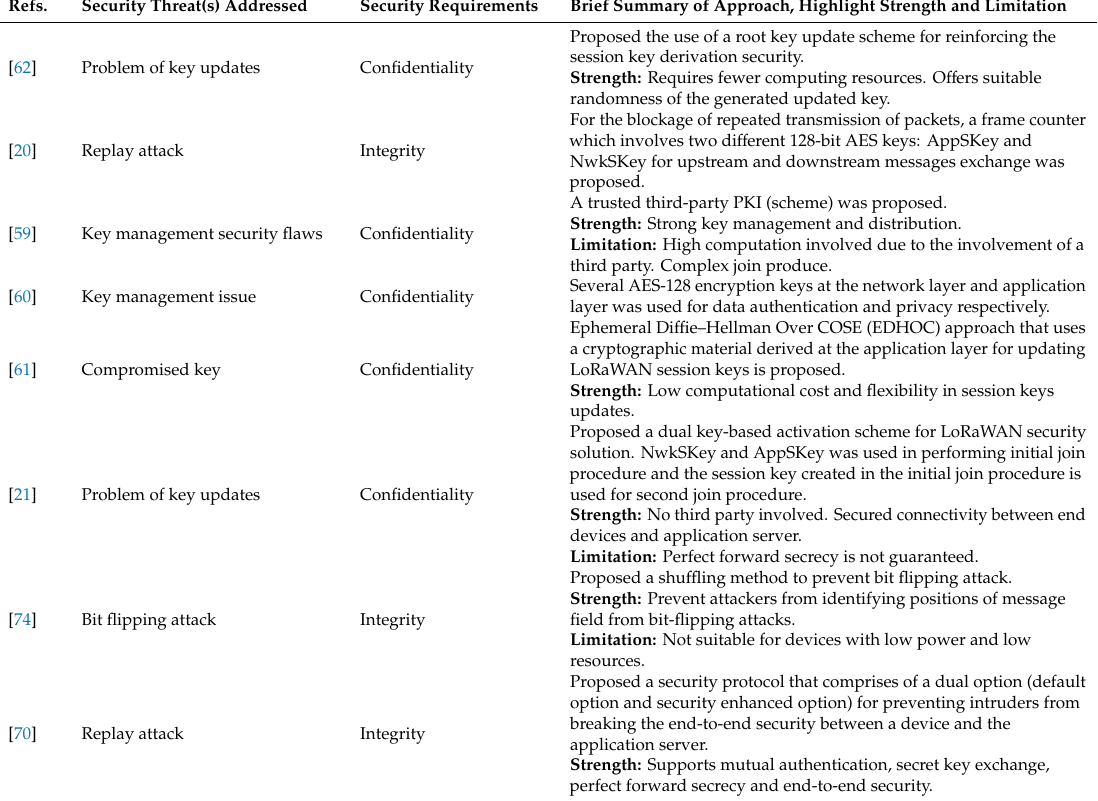
Table 2. A Comparison of Di ff erent Scheme Employed to Prevent LPWAN Attack.